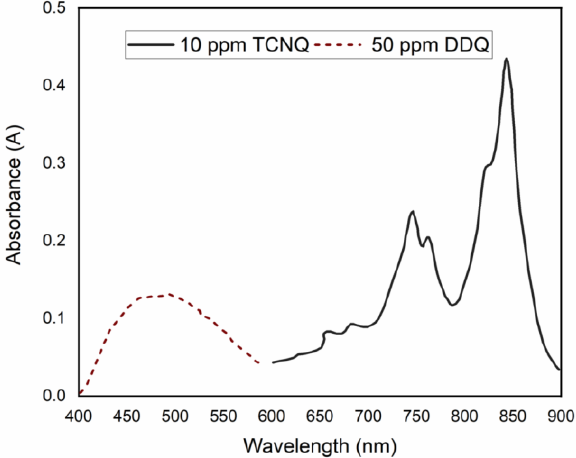
Figure 1. Absorbance curves of KT-DDQ and KT-TCNQ complexes.